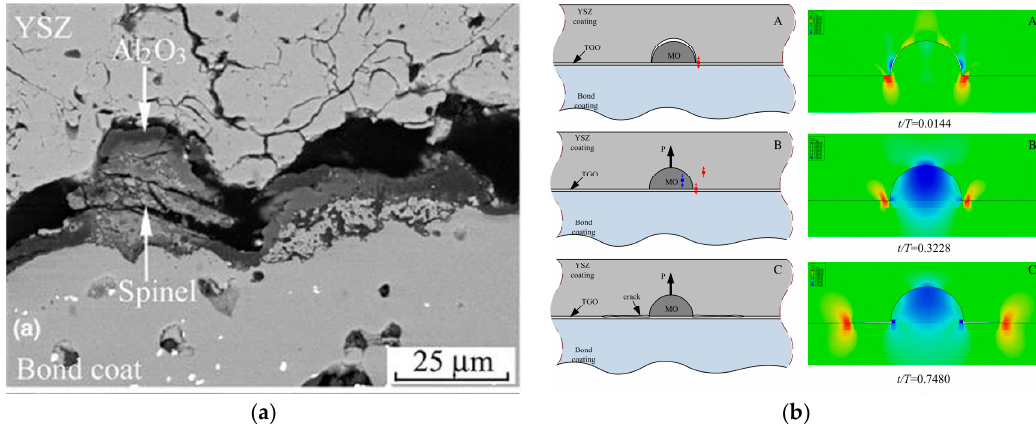
Figure 6. The local growth of mixed oxide (MO); ( a ) the local MO induces the failures of top ceramic coat (TC) [73]; ( b ) the numerical model and results of the local MO growth [75]; Among, the thermal expansion mismatch of MO and TC induces the interfacial tensile stress and debonding at stage A, the growth of MO jacks TC up and induces the interfacial tensile stress at stage B, and the growth of local MO induces the interfacial delamination at stage C.